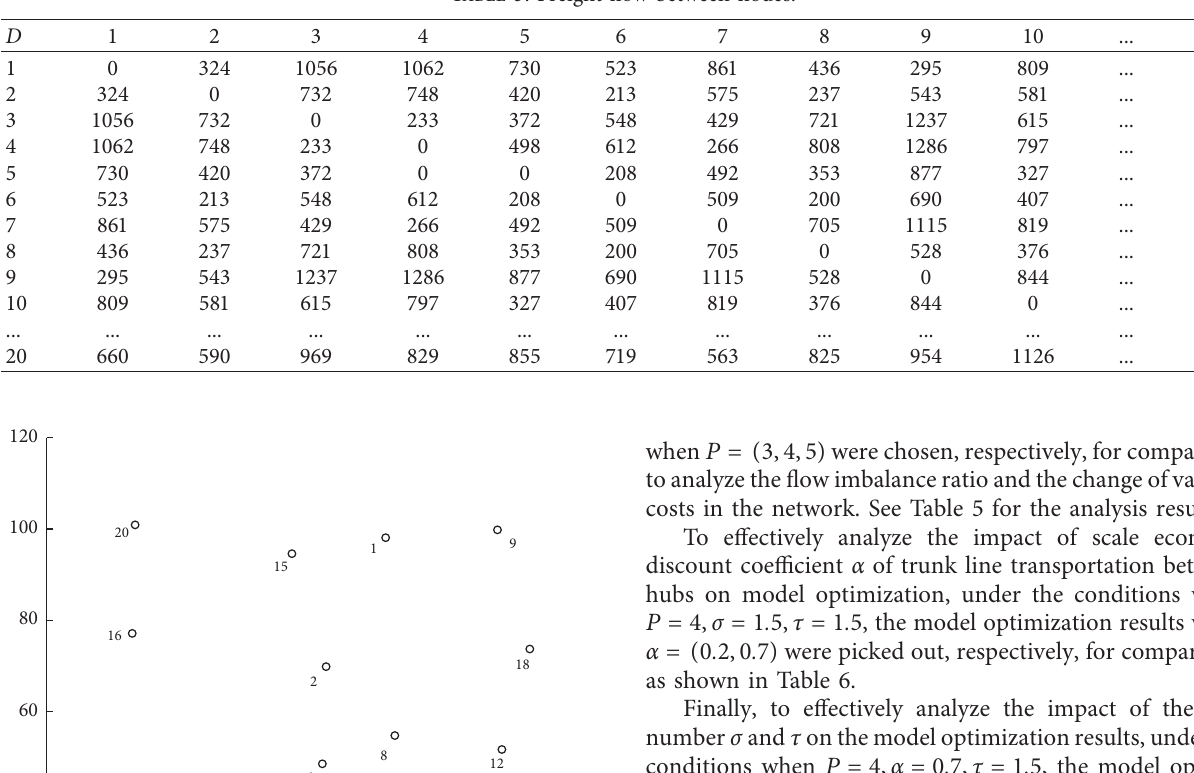
Table 3: Freight flow between nodes.